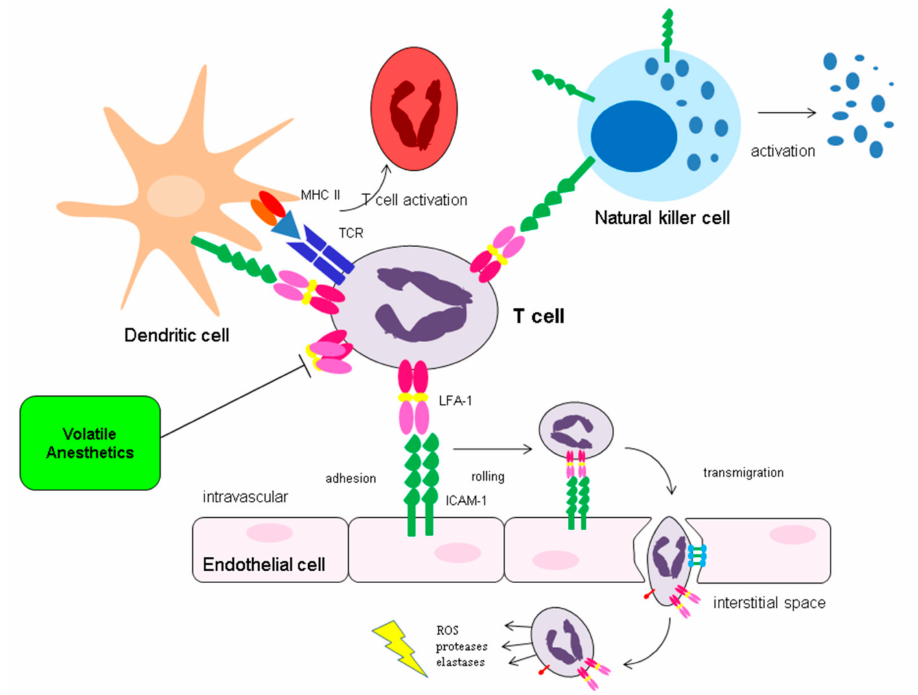
Figure 4. Interaction of LFA-1 with its ligands and consequences. Upon activation of the leukocyte by chemokines or antigens, lymphocyte function antigen-1 (LFA-1) undergoes conformational changes, facilitating its ability to bind with its ligand, via a process which is called inside-out signaling. The most important ligand for LFA-1 is intercellular adhesion molecule 1 (ICAM-1), of which expression on endothelial cells, antigen presenting cells (APCs) and other cells is increased upon IRI. Interaction of LFA-1 with endothelial ICAM-1 assures firm adhesion of the leukocyte to the endothelial cells and facilitates transmigration of the leukocyte into the interstitium. In the case of natural killer (NK) cells, LFA-1–target cell ICAM-1 interaction is necessary for activation of the NK cell and lysis of the target cell. LFA-1 activation on T cells facilitates APC binding and is involved in T cell activation. VA are able to inhibit activation of LFA-1, keeping it in its folded state. MHC-II: major histocompatibility complex II; TCR: T cell